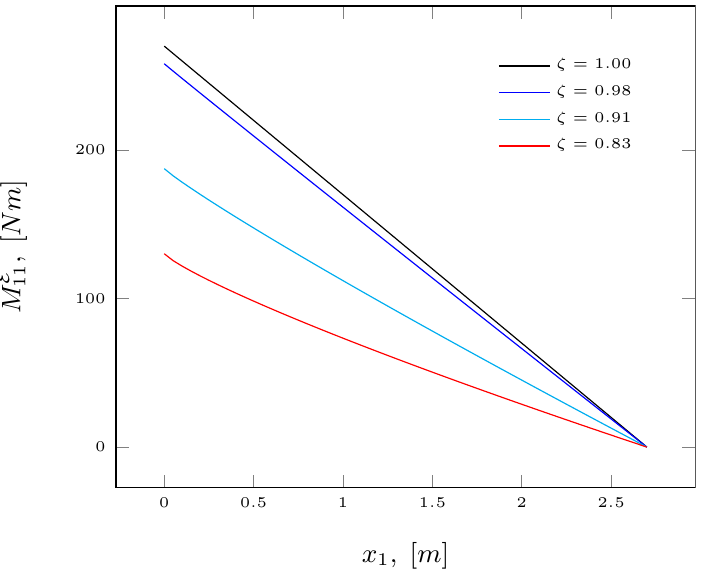
Figure 6. Bending moment for the Euclidean beam ( ζ = 1) and fractal beams with: ζ = 0.98, ζ = 0.91 and ζ =